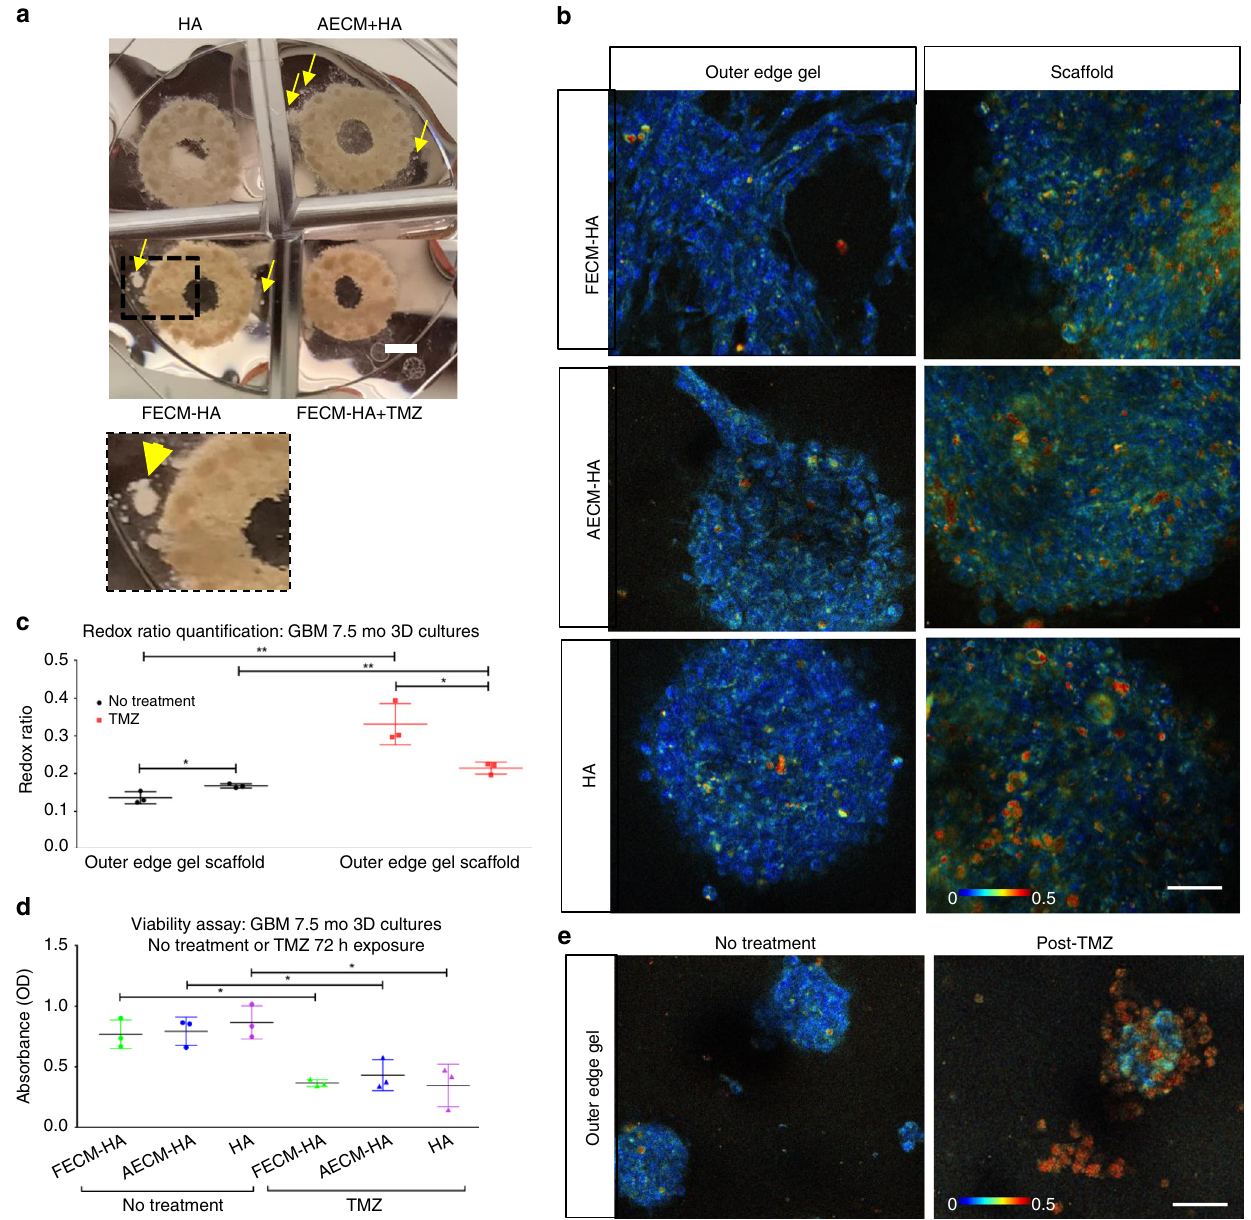
Fig. 7 Live metabolic imaging of glioblastoma cultured in 3D silk-HA-ECM constructs. a Macroscopic views of the GBM spheres within silk-HA-ECM constructs, post- DMSO (no treatment control) or temozolomide (TMZ) exposure. Scale bar, 2 mm. b Representative redox ratio images from endogenous metabolic co-factors FAD and NADH within GBM cells in 3D silk-HA constructs at 2 mo post-gel addition and 7.5 mo post cell seeding, with right panel showing images taken within the scaffold portion and left panel with images taken in the outer edge gel of the construct, respectively. Scale bar, 50 µ m. Image heatmap is the same for panel images and re fl ects varying redox ratio intensities. c Redox ratio quanti fi cation corresponding to outer edge gel areas and within scaffold areas, post-DMSO or TMZ exposure. Unpaired two-tailed t -tests between separate pairs; n = 3 per condition (multiple areas imaged per condition),** p < 0.0081, * p < 0.0321, df = 4, t > 3.228. d Wst-1 bulk viability assay at 7.5 mo in 3D GBM silk-HA cultures post- DMSO and TMZ exposure. Unpaired two-tailed t -test between separate pairs, * p < 0.0221, df = 4, t > 3.635. e Representative redox ratio images within GBM cells in 3D silk- HA constructs at 2 mo post-gel addition and 7.5 mo post cell seeding. 2-photon signals were obtained post- 72 h exposure to either DMSO or TMZ. Scale bar, 50 µ m. Error bars indicate mean ± s.d, Source data are provided as a Source Data fi